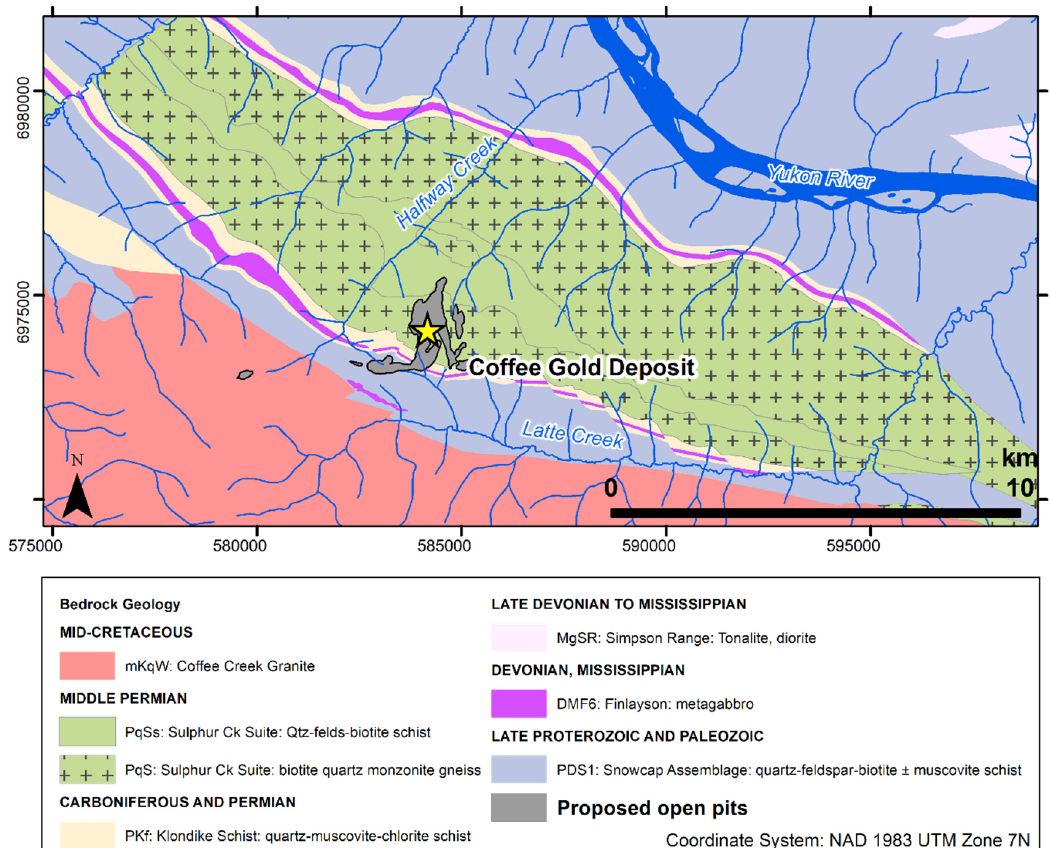
Figure 1. Geological map showing the bedrock geology underlying the Co ff ee deposit and the proposed mine pit locations. Bedrock geology from ref.